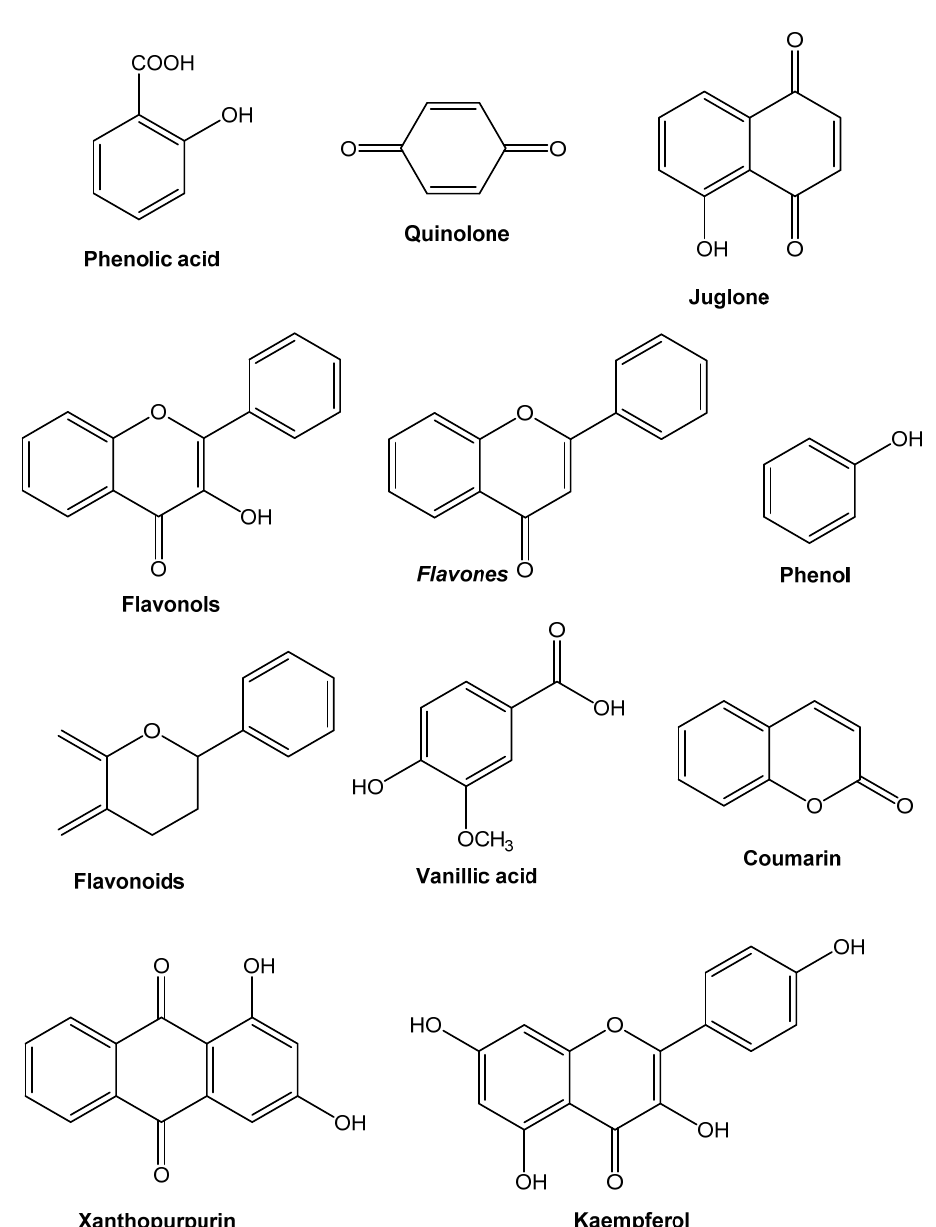
Figure 1. Secondary metabolites presented significant antimicrobial properties from medicinal plants and phytochemicals.